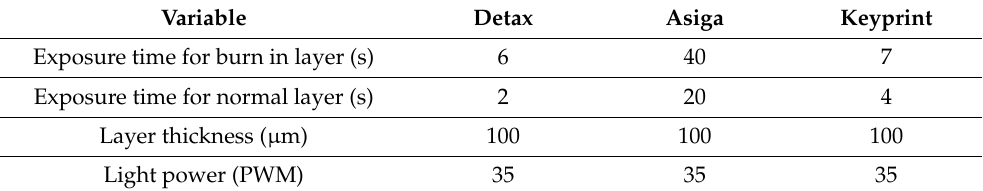
Table 1. Optimal settings empirically determined for the different resins tested.